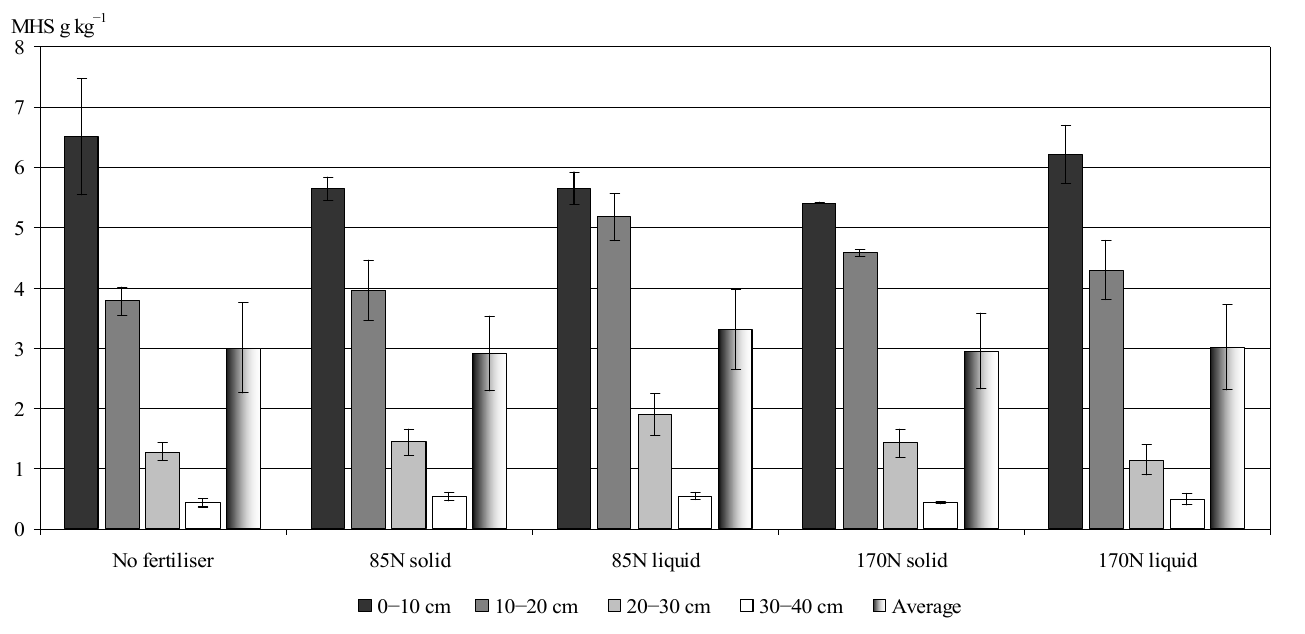
Figure 12. MHS content in the grassland in Fluvisol, 2019.